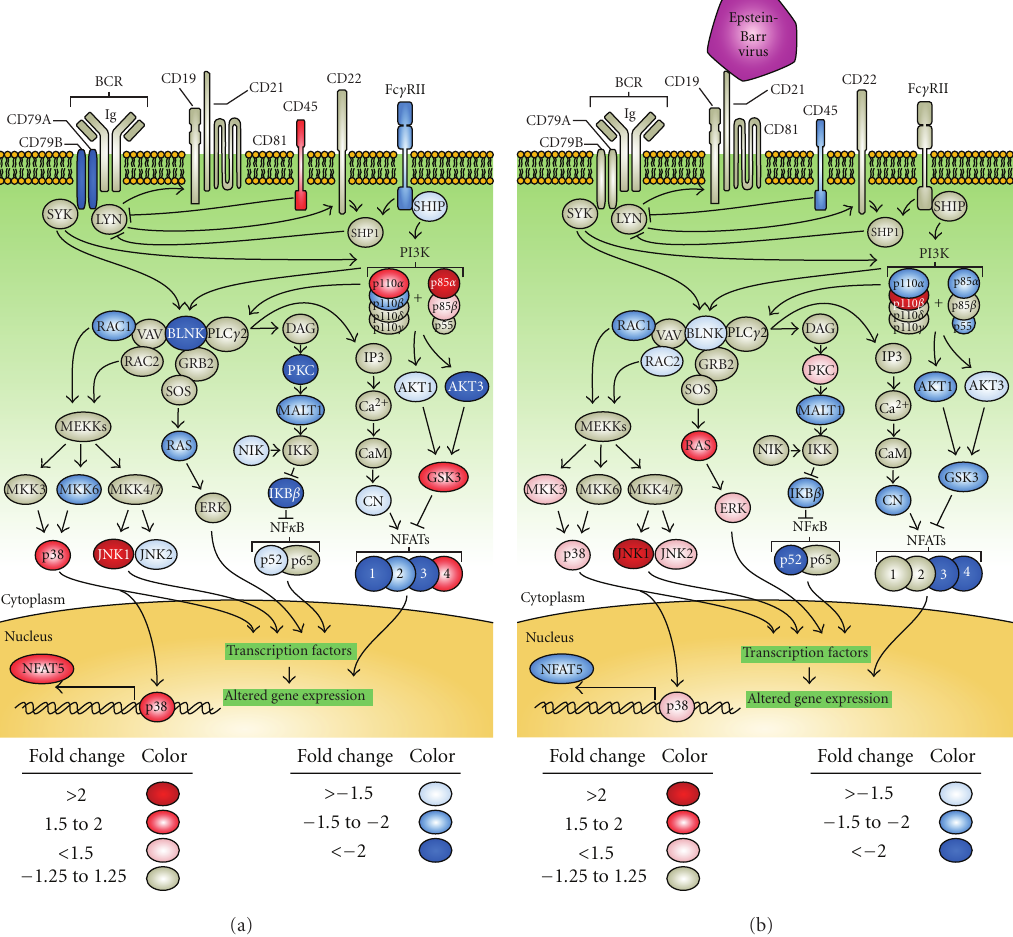
Figure 3: Association of the canonical B-cell receptor pathway with IRF5 haplotype. BCR pathway genes demonstrate a significant enrichment of changes in expression levels based on IRF5 haplytype, as determined by Ingenuity analysis ( P < 0 . 01). The unstimulated condition is shown on the left, and the EBV-exposed condition is shown on the right. Genes with altered expression based on haplotype are shown as either blue or red. BLNK: B cell linker, CAM: Calmodulin, CN: Calcineurin, ERK: extracellular signal-regulated kinase, FCGR2B: fragment crystallizable γ receptor 2B, INPP5D: inositol polyphosphate-5-phosphatase D (SHIP), MALT1: mucosa associated lymphoid tissue lymphoma translocation gene 1, and PKC: protein kinase